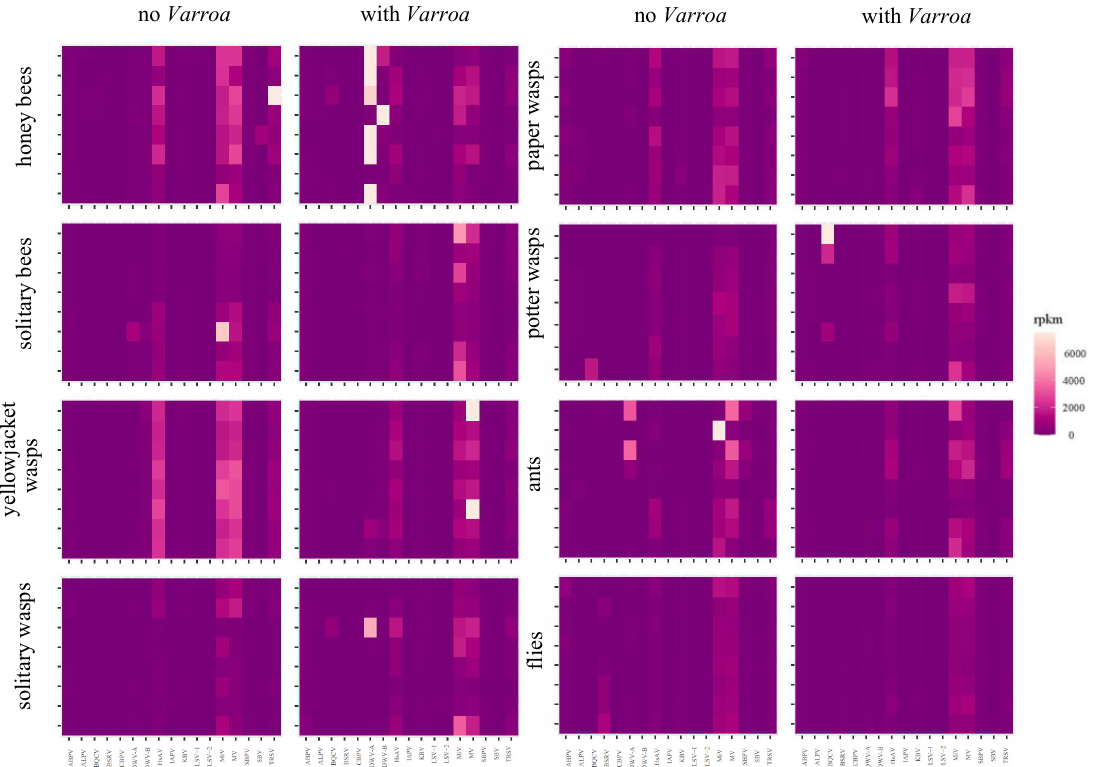
Figure 7. Heatmap showing the amounts of bee virus-associated reads (RPKM) in each individual sample, presented grouping each taxon and further separating by Varroa status (left panels no Varroa , right panels with Varroa